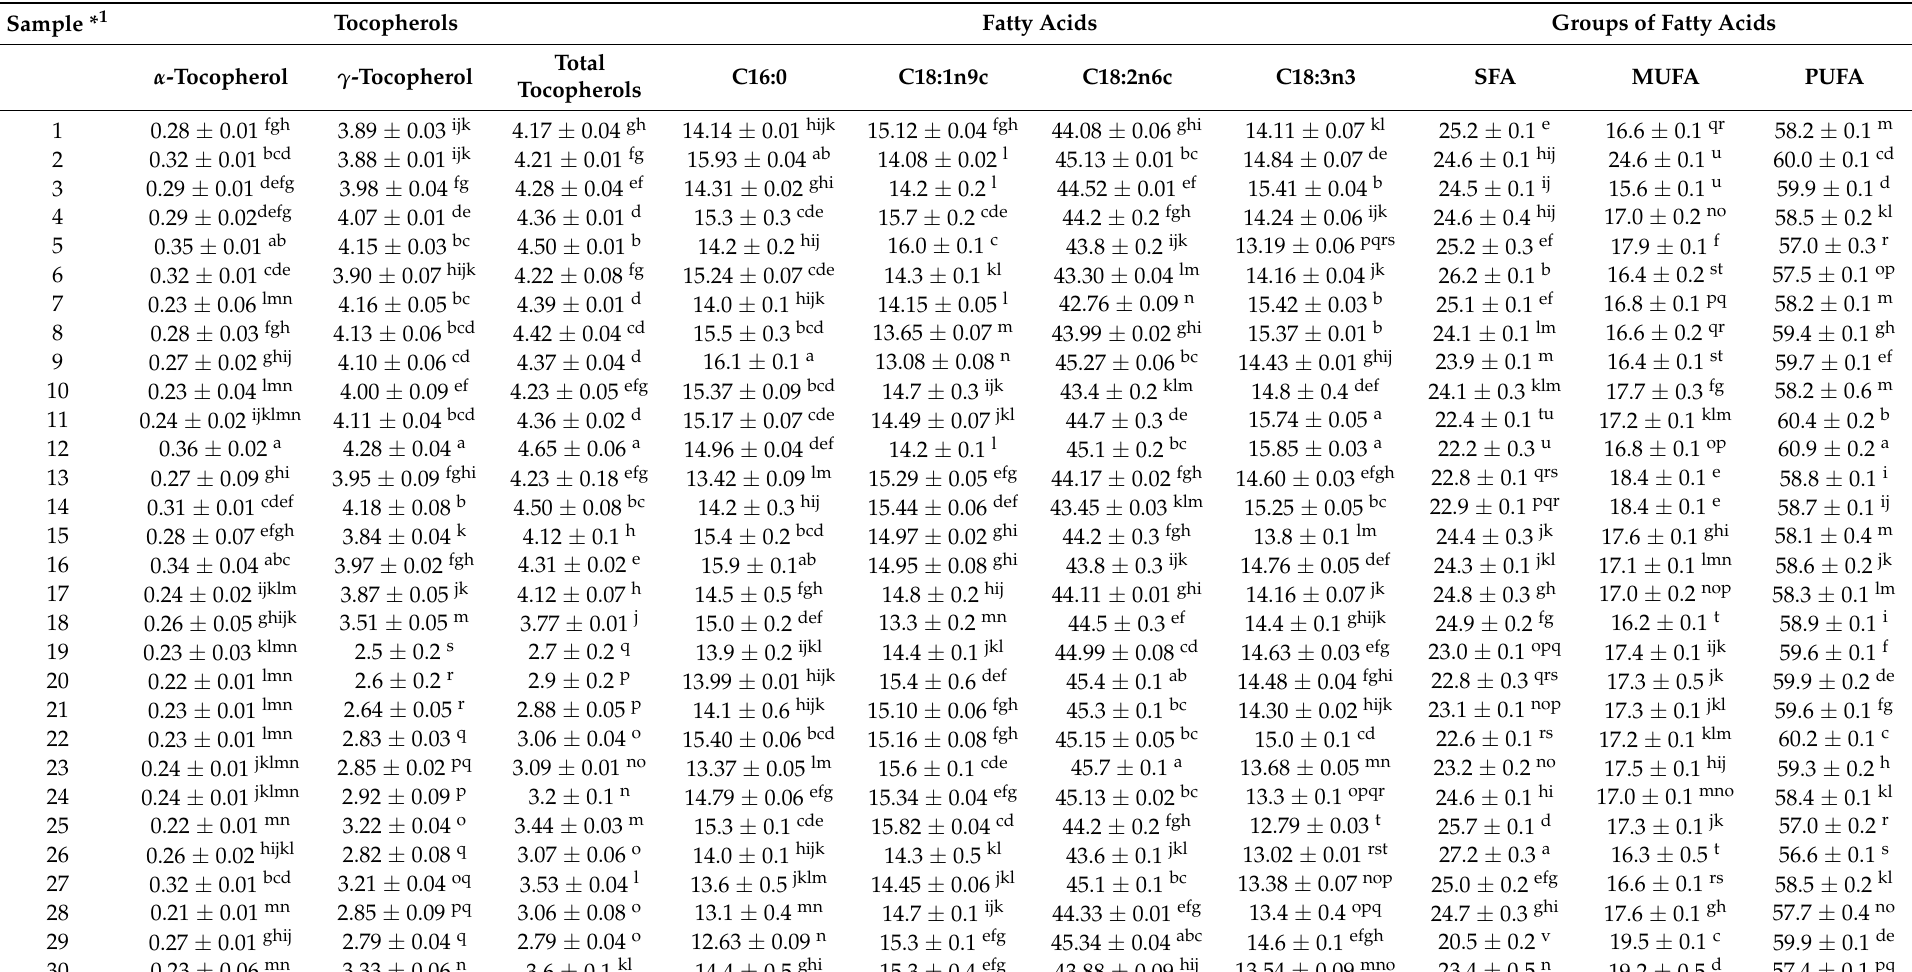
Table 4. Composition regarding tocopherols (mg/100 g fw) and fatty acid composition (%) of the studied Pardina lentil “Lenteja de Tierra de Campos” (%) (mean ± SD; n = 3). The most abundant fatty acids and groups of fatty acids are